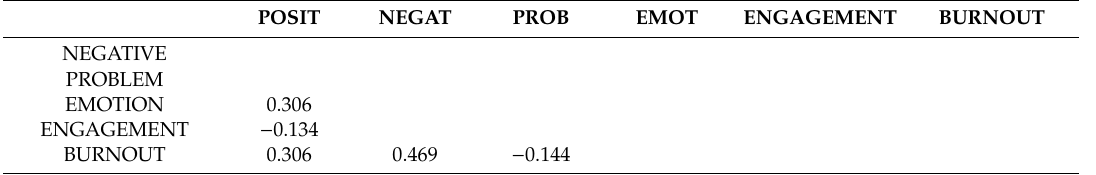
Table 8. Standardized Indirect E ff ects (Default model). Learning